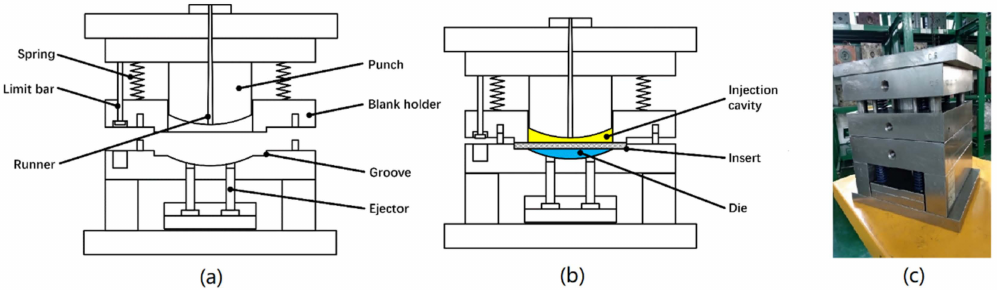
Figure 8. Final state of the bias-extension test.